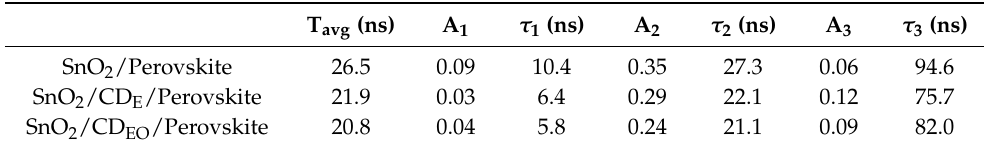
Table 1. PL decay parameters for SnO 2 /Perovskite, SnO 2 /CD E /Perovskite, and SnO 2 / CD EO /Perovskite films.